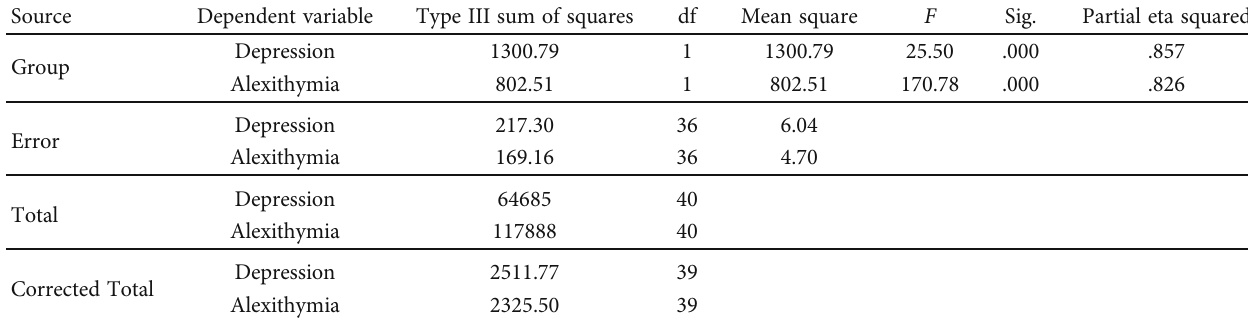
Table 5: Tests of between-subject e ff ects.